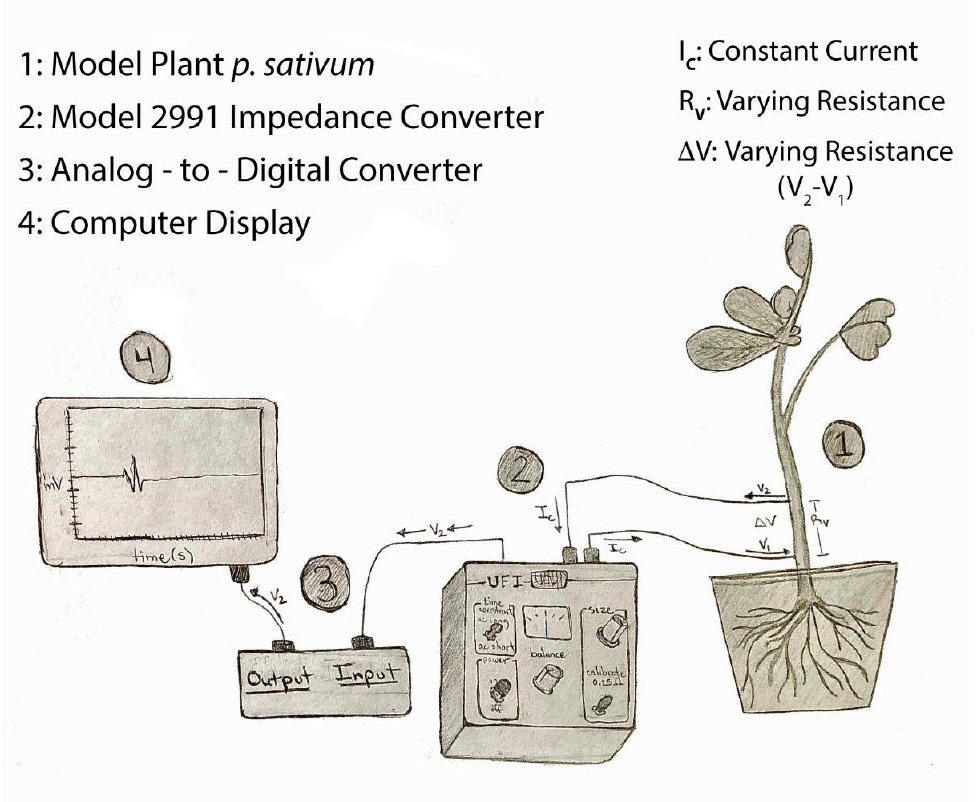
Figure 1. A schematic of the recording arrangement for impedance measurements with a plant being monitored for a change in resistance.